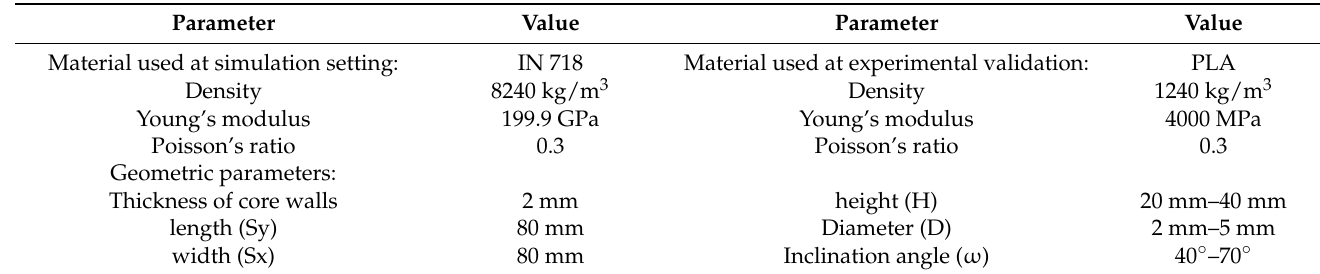
Table 1. Geometric parameters of LS core and its material